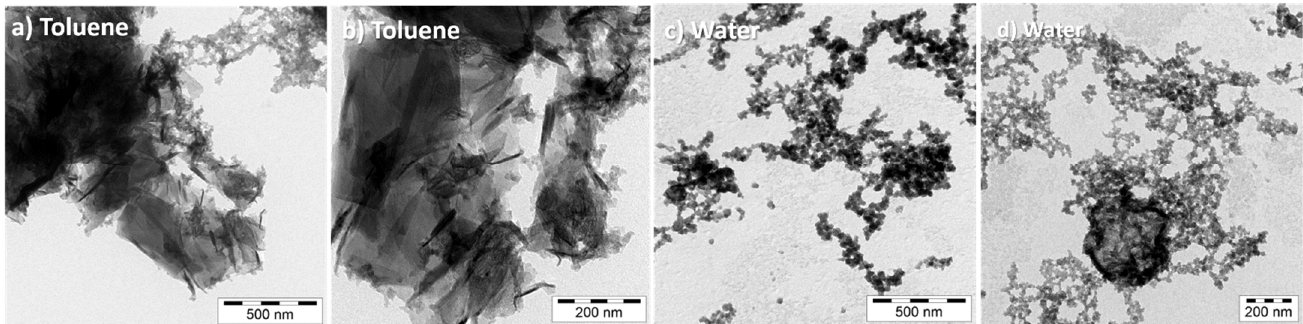
Figure 11. Nanostructures generated using laser ablation on a graphite target covered with a thin liquid film. Liquids: ( a , b ) toluene and ( c , d ) water. liquid film. Liquids: ( a , b ) toluene and ( c , d )